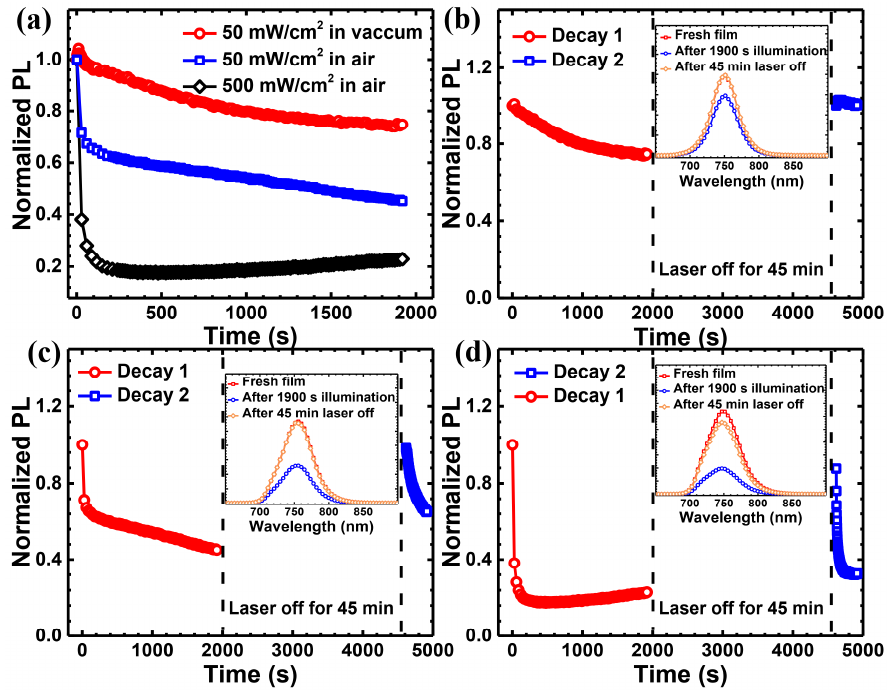
Figure 1. ( a ) Normalized time-dependent steady-state PL intensity of quasi-2D perovskites of PEA 2 MA 2 Pb 3 I 10 under continuous illumination using a 635 nm laser source under different condi- tions. ( b ) The PL intensities over time of PEA 2 MA 2 Pb 3 I 10 under laser excitations at 50 mW/cm 2 in a vacuum, ( c ) the laser excitations at 50 mW/cm 2 in an ambient environment, and ( d ) the laser excitations at 500 mW/cm 2 in an ambient environment. The respective illumination stops at 1900 s for a dark treatment of 45 min before resumption. The corresponding PL spectra of the PEA 2 MA 2 Pb 3 I 10 film at various time points are shown in the inset of the respective figure panel. After a darkness treatment of 45 min, the PL spectrum does not change, although its PL intensity cannot fully recover. This suggests that the decay of the PL intensity up to 500 mW/cm 2 is not due to the decomposition of perovskites, proving the stability of the